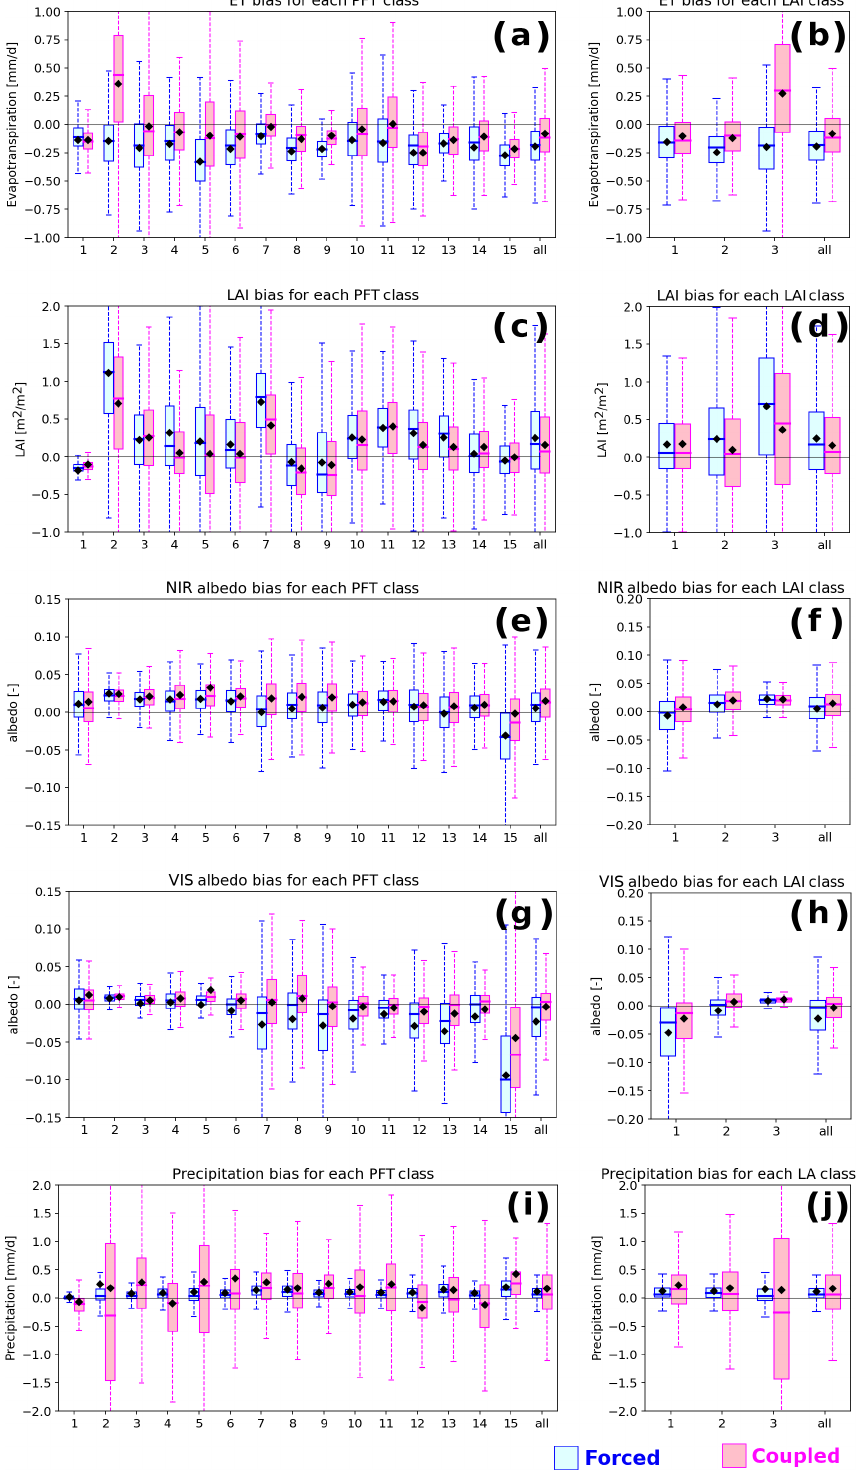
Figure 7. Box plots of mean biases (simulated minus observed values) of ET, LAI, NIR/visible albedo (forced/coupled), and precipitation (coupled only) against each class of PFT and LAI. (a, b) ET bias. (c, d) LAI bias. (e, f) NIR albedo bias. (g, h) Visible albedo bias. (i, j) Precipitation bias vs. PFT and LAI classes, respectively. Legends and axes are the same as in Fig. 6, and each class of landscape factors (i.e., x axis) is defined in Table